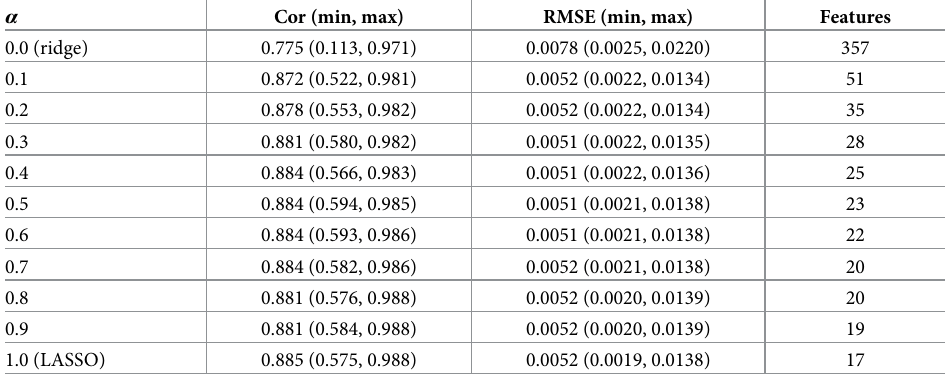
Table 1. Nowcast performance for elastic net models of α = 0.0, 0.1, ... , 1.0. The correlation is the average correla- tion over all 55 region/season pairs, while the min and max correlations are the min and max correlations over all region/season pairs. Similarly for the RMSE. The average number of estimated non-zero features are shown in the “Features” column. Ridge regression is qualitatively worse than all other α > 0 models. There is little difference between all α � 0.1 models with respect to correlation and RMSE. The number of non-zero features tends to decline as an increasing function of α . α Cor (min, max) RMSE (min, max) Features 0.0